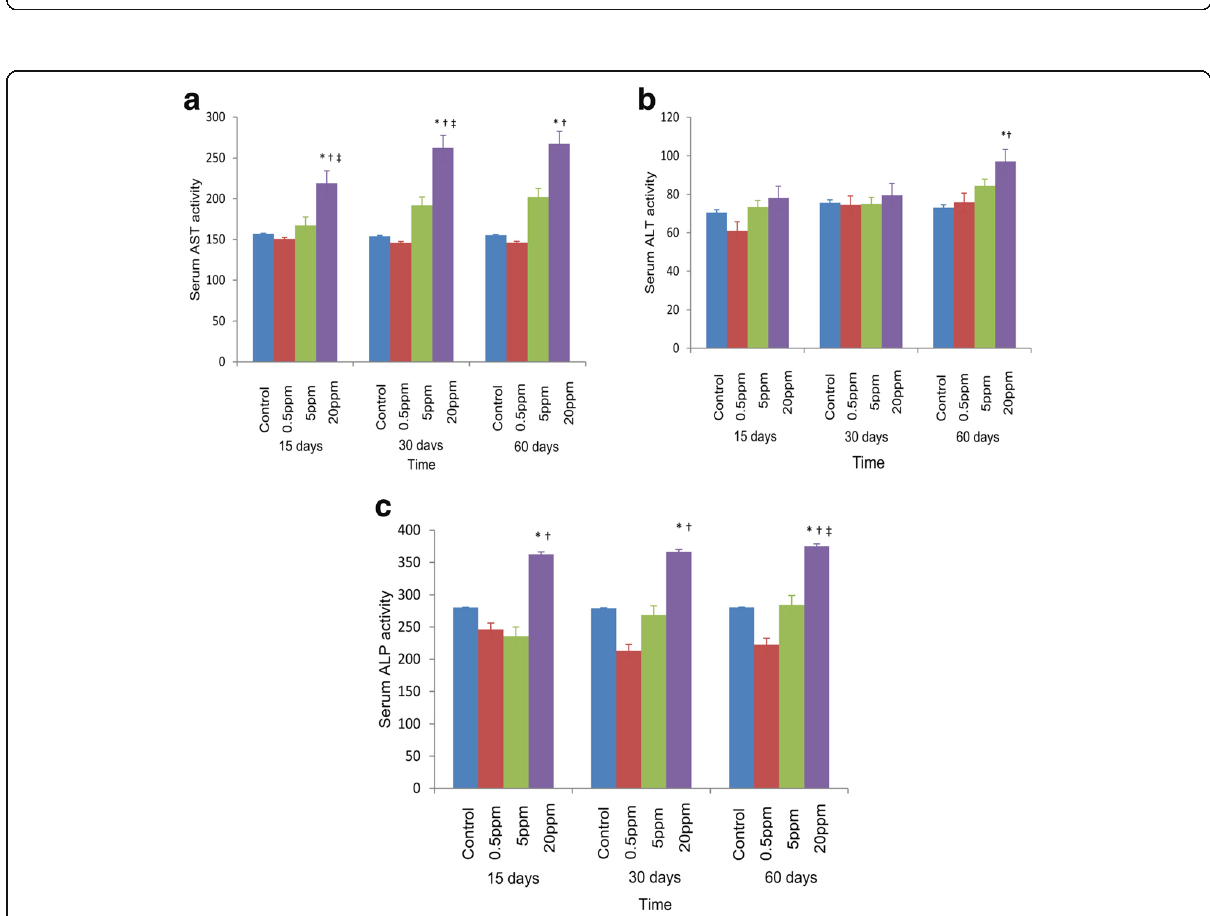
Fig. 4 Effects of fluoride on the activity of serum aspartate aminotransferase (AST), alkaline phosphatase (ALP), and alanine aminotransferase (ALT) in rats after 15, 30, and 60 days. a Effects of fluoride on the activity of serum aspartate aminotransferase (AST) in rats after 15, 30, and 60 days. * p <0.05 compared with control, † p <0.05 compared with 0.5 ppm, ‡ p <0.05 compared with 5 ppm. b Effects of fluoride on the activity of serum alanine aminotransferase (ALT) in rats after 15, 30, and 60 days. * p <0.05 compared with control, † p <0.05 compared with 0.5 ppm. c Effects of fluoride on the activity of serum alkaline phosphatase (ALP) in rats after 15, 30, and 60 days. * p <0.05 compared with 0.5 ppm, † p <0.05 compared with 5 ppm, ‡ p <0.05 compared with control. Error bars represent standard